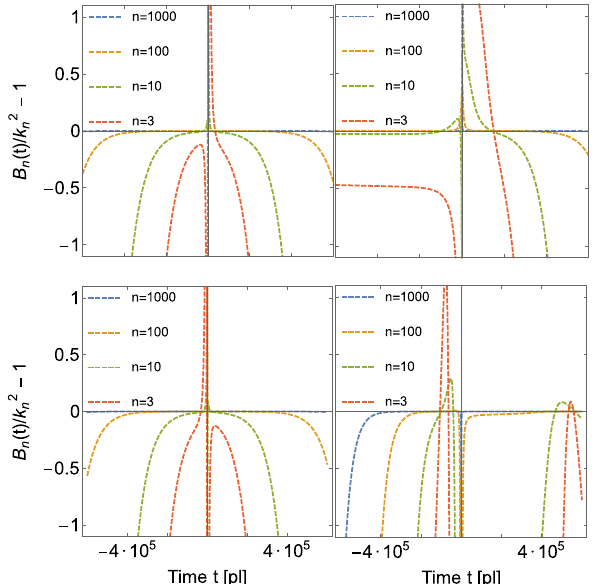
Fig. 3 Behaviour of the functions B n ( t ) around the bounce t = 0, for differentwavenumbers n andinitialconditions,inthecaseofaquadratic potential. top left: {− 0 . 99 , + 1 } , top right: {− 0 . 467 , + 1 } , bottom left: {− 0 . 99 , − 1 } , bottom right: {− 0 . 41 , − 1 } are drawn in Fig. 2, for different values of { w( 0 ), sgn ( and n . The “deviations”, B n ( t )/ k 2